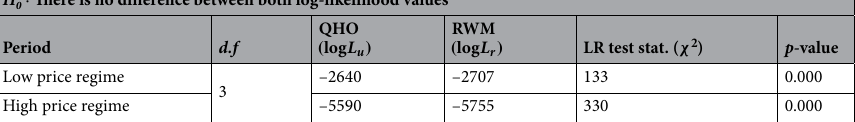
Table 5. LR test results. The LR test assesses the adequacy of the QHO model over RWM where outliers Std.Err. are excluded. The result indicates that the QHO that deviate from the mean by more than 2.58 × (unrestricted) model explains the data better than the RWM (restricted) model. The formula of the LR 2log ( L r / L u ) , where L u and L r denote the likelihood of the respective models such as test statistic is LR = − QHO and RWM. The test statistic follows χ 2 distribution with the degree of freedom ( d.f. ) 3, which refers to the number of constrained parameters. The p -value indicates that the unrestricted model outperforms the restricted